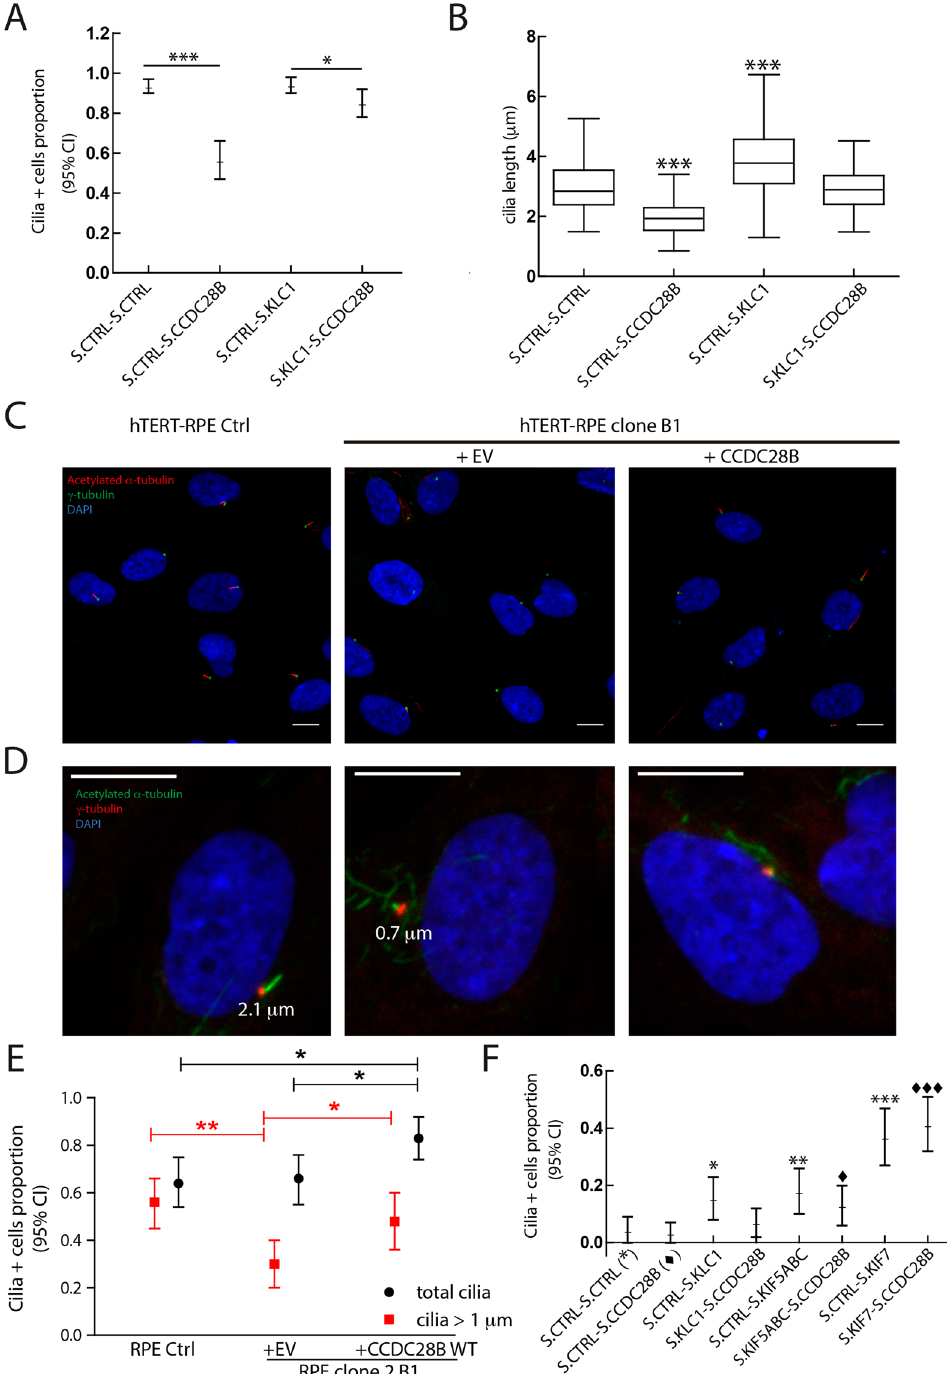
Figure 4. Kinesin 1 requires CCDC28B to regulate cilia length. ( A ) The proportion of cilia-positive cells is significantly reduced upon CCDC28B KD but not KLC1 KD (hypothesis test for proportions). Co-transfection of the KLC1 stealth oligo rescues the phenotype of CCDC28B KD cells. ( B ) CCDC28B KD (118 analyzed cilia) and KLC1 KD (155 cilia measured) cells show significantly shortened and elongated cilia respectively. Cilia were of control length in cells co-transfected with both stealth oligos (115 cilia). Statistical test: one-way ANOVA; *** P < 0.001. The amount of transfected oligos per condition was maintained constant using a control stealth oligo. ( C ) CCDC28B CRISPR clone B1 was analyzed by immunofluorescence and confocal microscopy using anti-acetylated tubulin (red), anti γ -tubulin (green) and DAPI (blue) to stain cilia, basal bodies and nuclei respectively. Untreated hTERT-RPE cells were used as control and CCDC28B CRISPR clone B1 transfected with pCS2 + _CCDC28B wt was used to show rescue and specificity of the cilia phenotype. ( D , E ) Clone B1 cells were analyzed to quantify the number of total cilia-positive cells (acetylated α -tubulin signal irrespective of length) and cells bearing “long” cilia of at least 1 μ m. Scale bars represent 10 μ m. ( E ) Quantification shows that